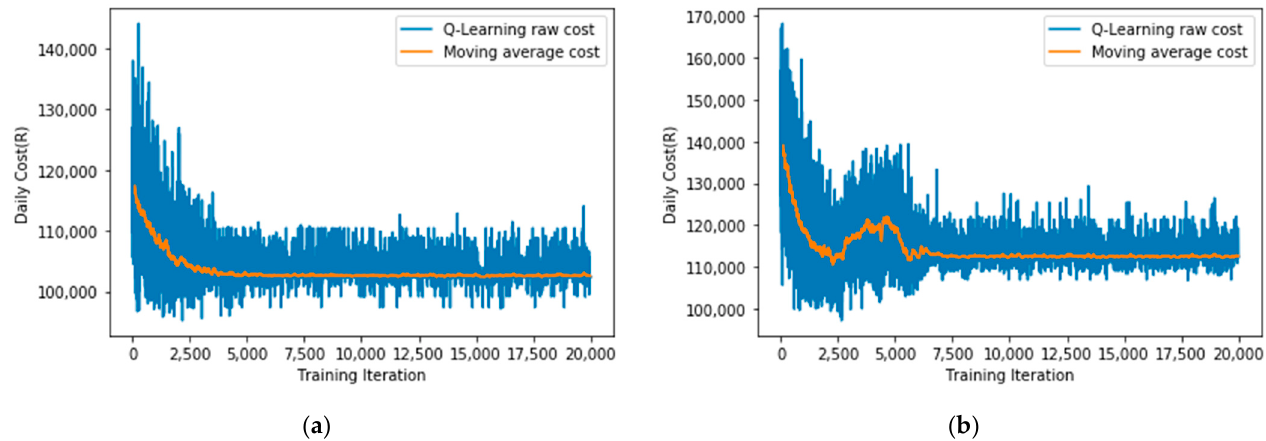
Figure 6. Daily operational cost against number of episodes; ( a ) trading algorithm ( b ) non-trading algorithm.